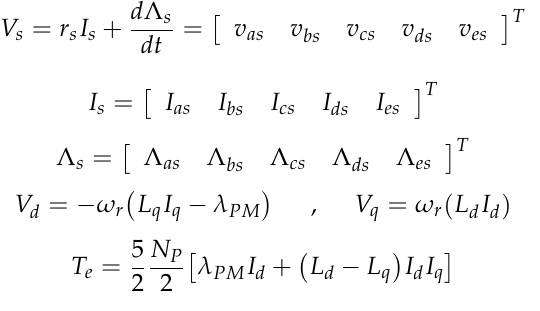
q-axis (Figure 6c):